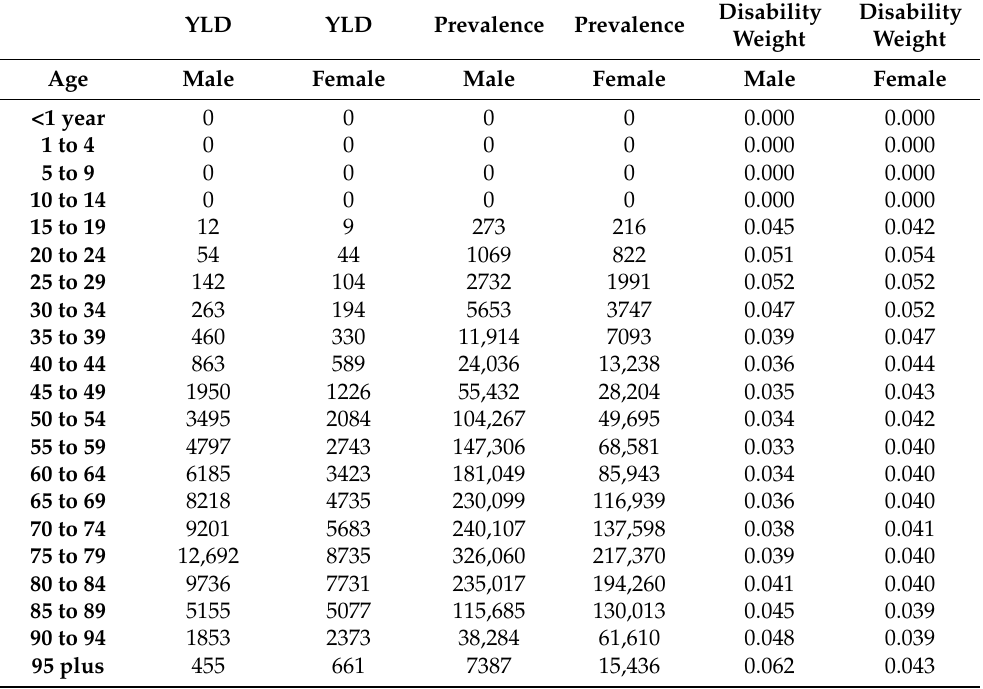
Table 2. Exemplary DW quantification for IHD and the year